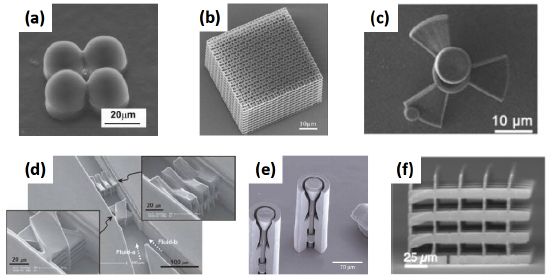
Figure 10: Three-dimensional micro- and nanostructures